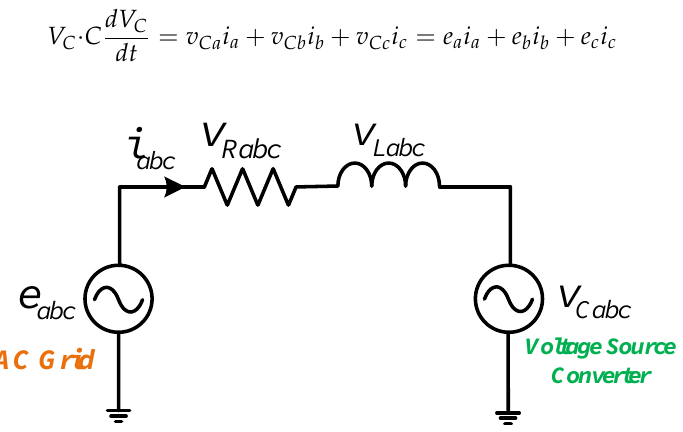
Figure 3. Equivalent circuit of a 3-phase AC/DC PWM converter.